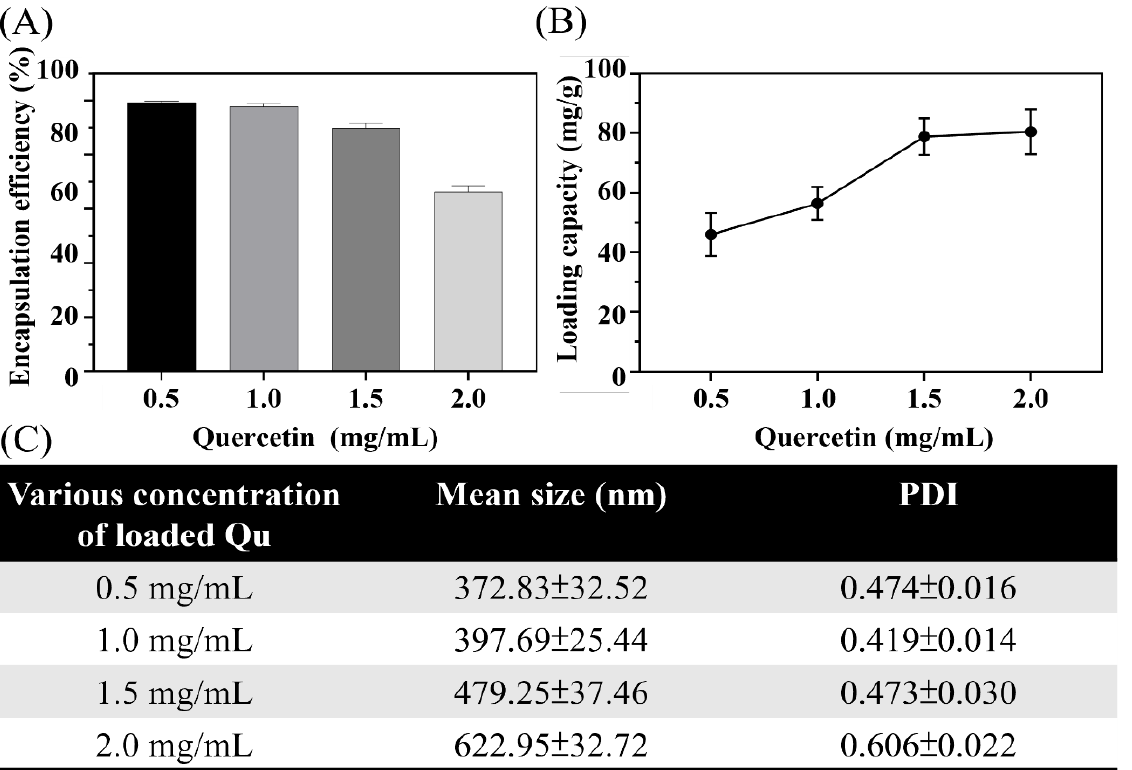
Figure 2. ( A ) Encapsulation efficiency and ( B ) loading capacity of Qu-encapsulated nanoparticles with various concentrations (0.5, 1, 1.5, 2 mg/mL). ( C ) Particle size distribution and polydispersity index (PDI) of Qu-encapsulated QAGN with various concentrations (0.5 – 2 mg/mL). Data are shown as mean ± SD ( n = 5).